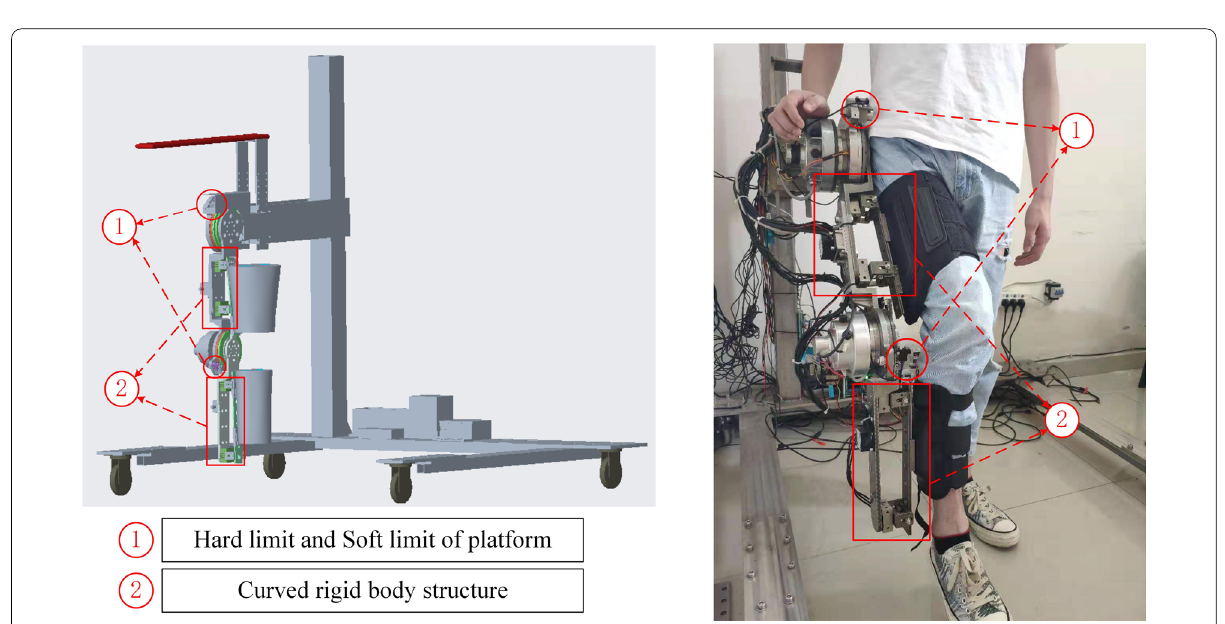
Figure 2 Mechanical structure of the 2-DOF lower limb exoskeleton